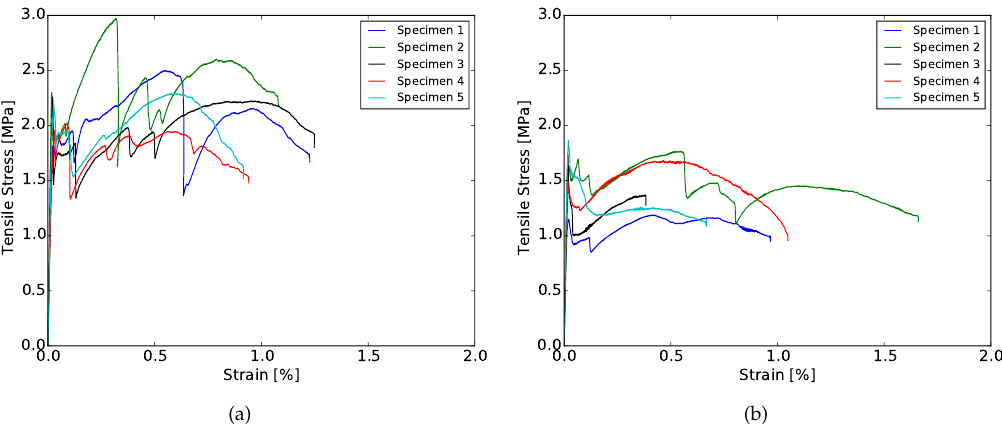
Figure 12. Stress–strain curves of specimens cured for 35 days resulting from uniaxial tensile tests in LPE. ( a ) XVA3PVA20; ( b ) YVA4PVA20-S05.